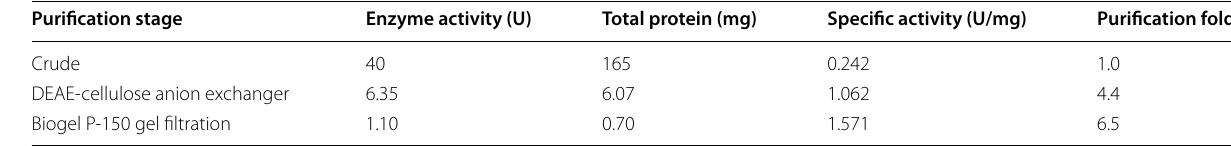
Table 1 Purification profile of lignin peroxidase from SE extract of Acinetobacter sp. Purification stage Enzyme activity (U) Total protein (mg) Specific activity (U/mg) Purification